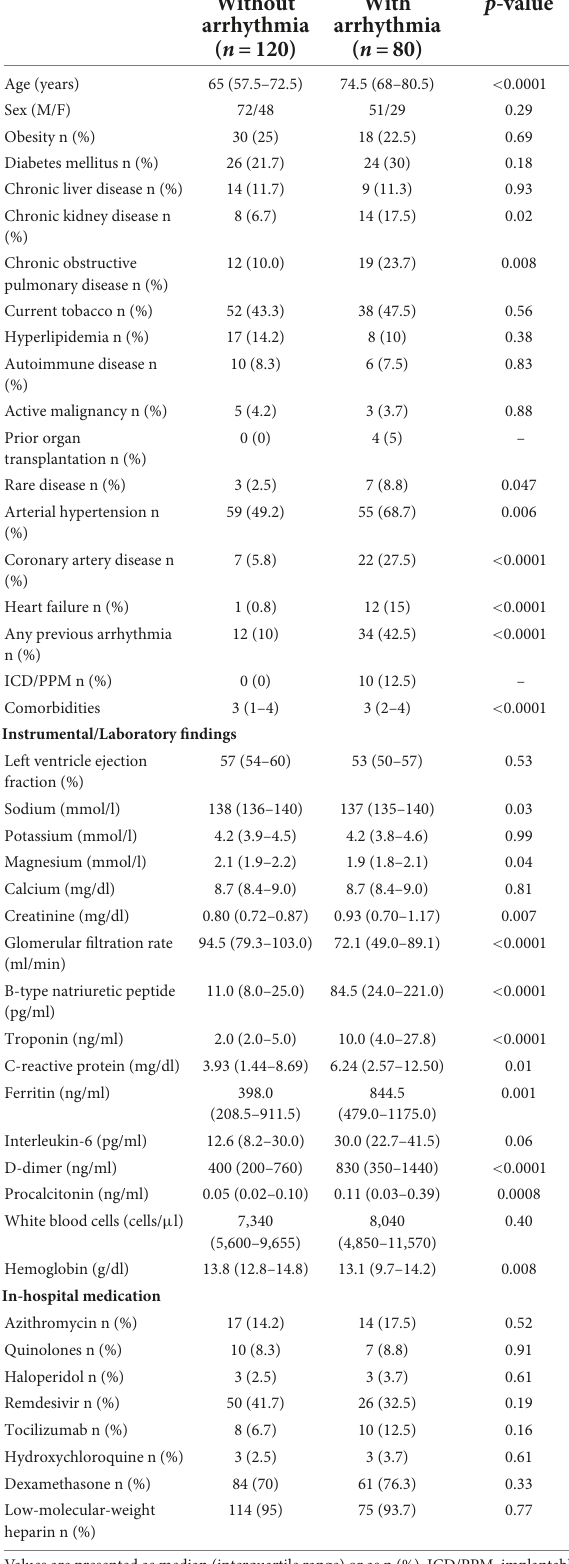
TABLE 1 Characteristics of patients monitored on cardiac